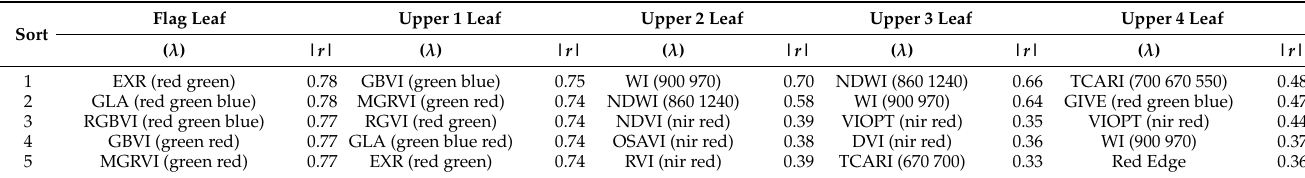
Table 4. Correlation between vegetation indices and nitrogen content from different leaf positions in winter wheat.